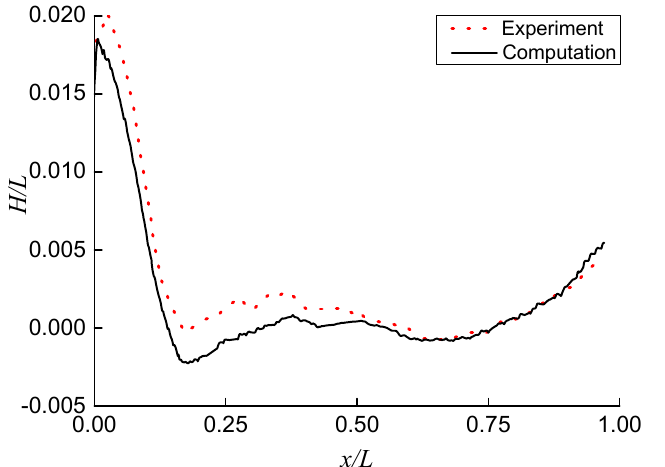
Figure 6. Comparison of wave elevation on hull surface obtained by computation and experiment for intact ship.